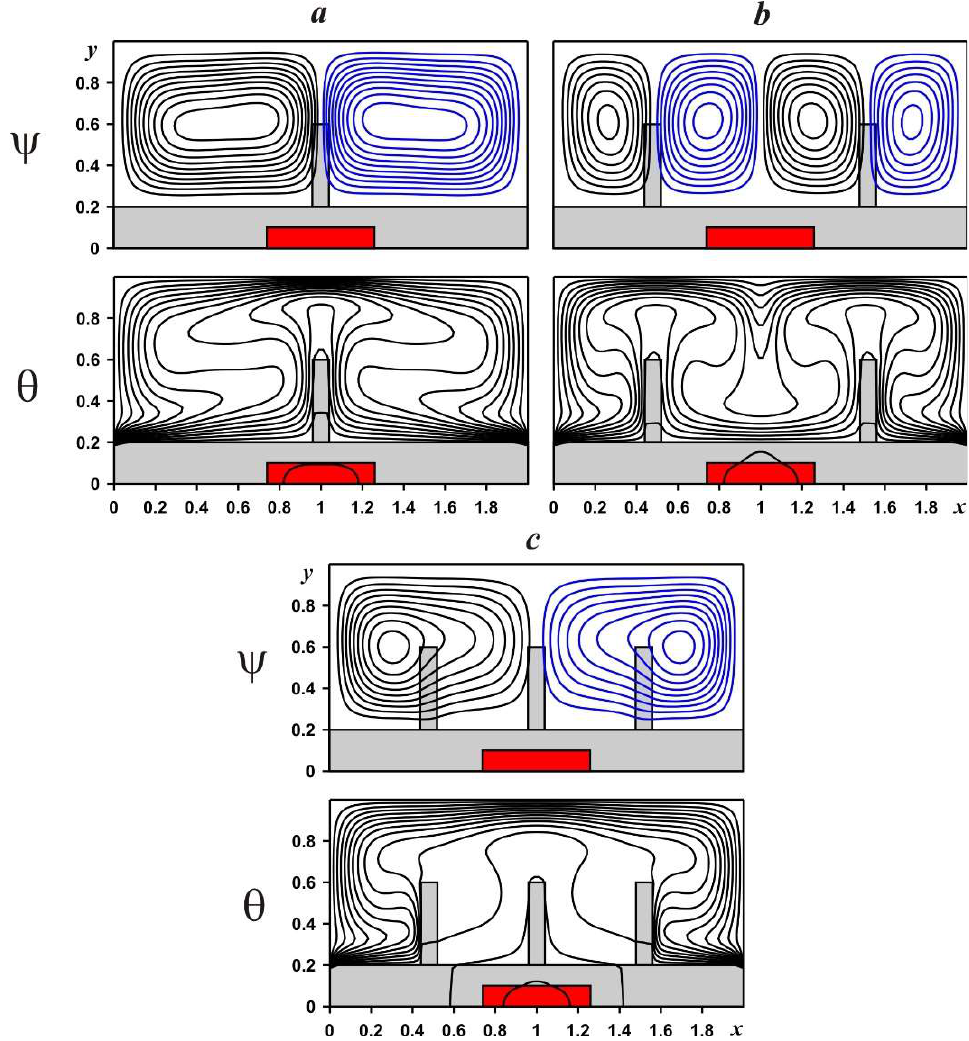
Figure 6. Streamlines and isotherms in a cavity with porous fins at Da = 10 − 5 and ε = 0.8: one fin—( a ), two fins—( b ), three fins—( c ).